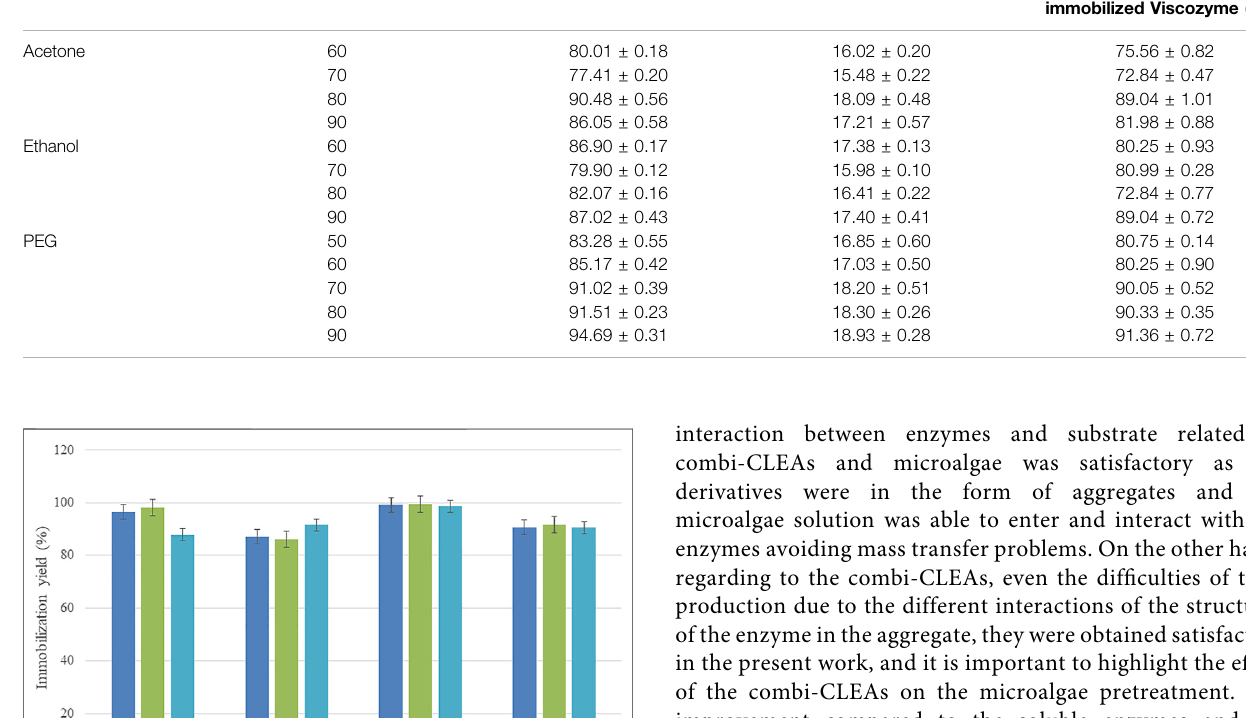
TABLE 3 | Immobilization performance of Viscozyme ® -CLEAs at different precipitant conditions. Precipitant type